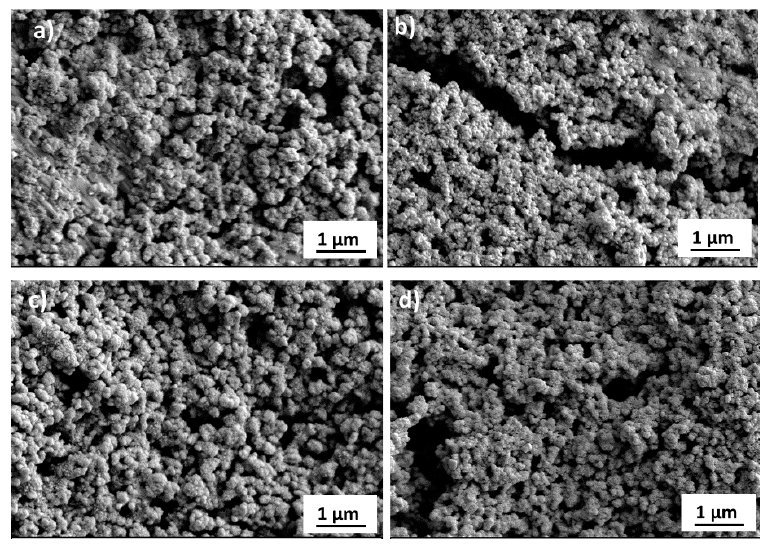
Figure 13. SEM images of ink_250 ( a ) and ink_300 ( c ) before the PEC test; and ink 250 ( b ) and ink_300 ( d ) after PEC measurements.